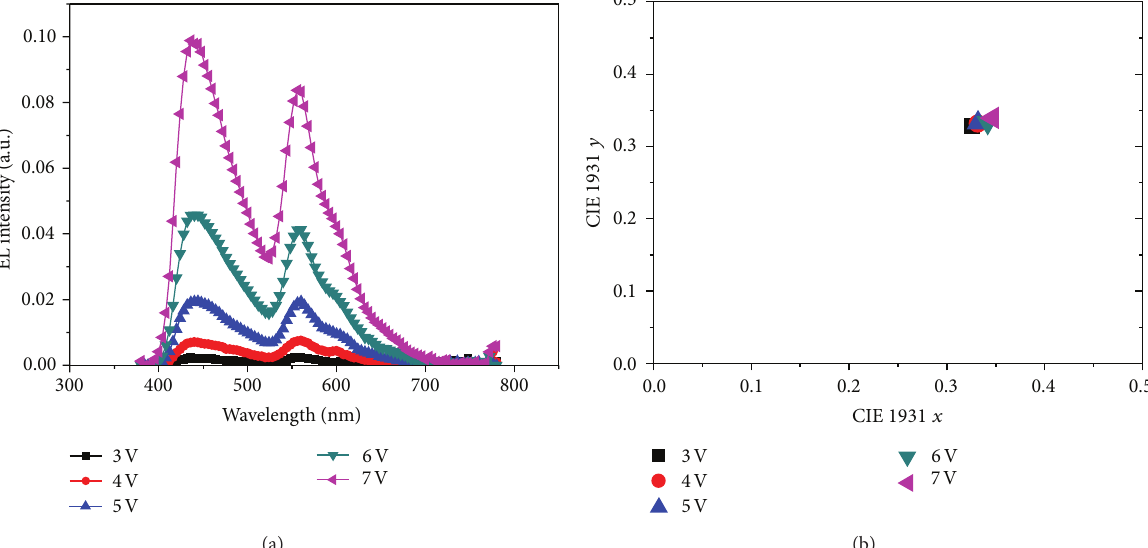
voltage increases from 6 V to 7 V, the CIE coordinates were, respectively, (0.341, 0.332) and (0.346, 0.339), and showed